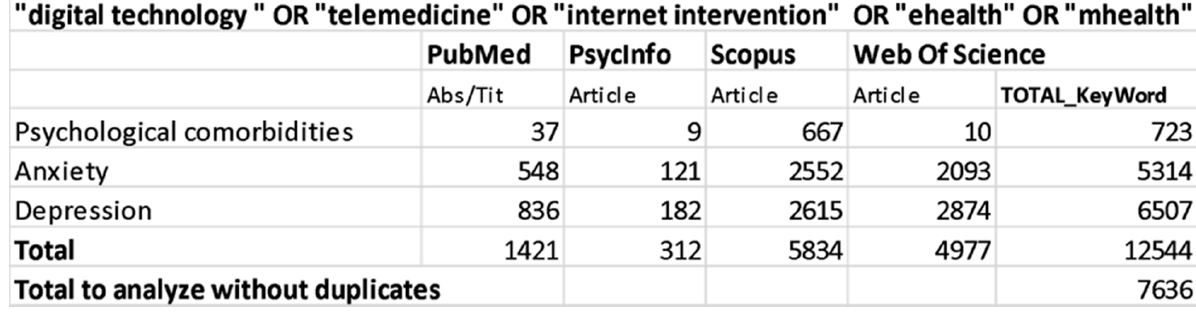
Figure 1. Data search strategy.